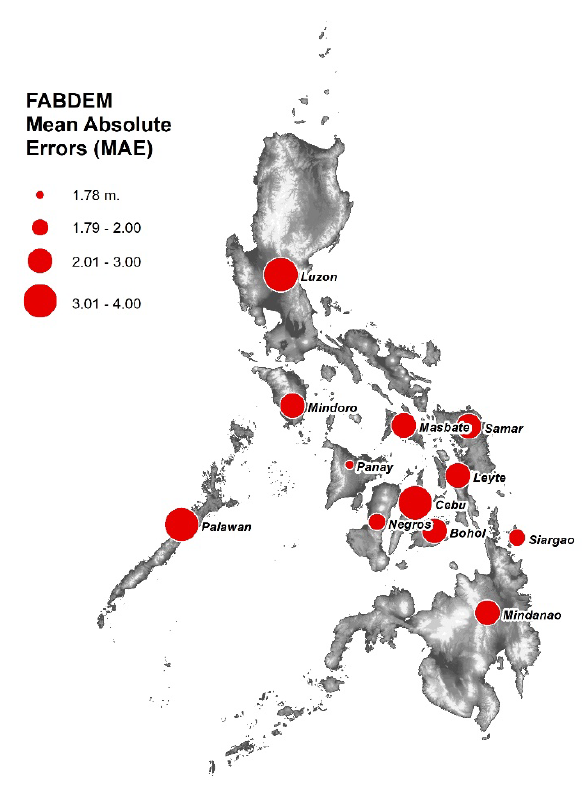
Figure 7. FABDEM MAEs at selected islands of the Philippines. The values illustrated are the average of the MAE calculated from the three sets of GCPs.